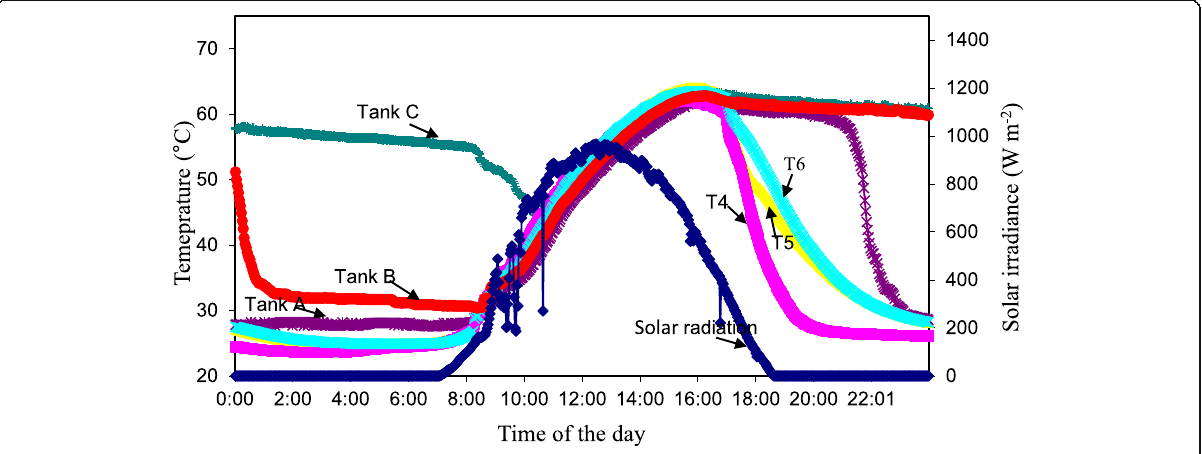
Fig. 5 Typical variation of water temperatures at Cluster exits and tank temperatures during a typical sunny day